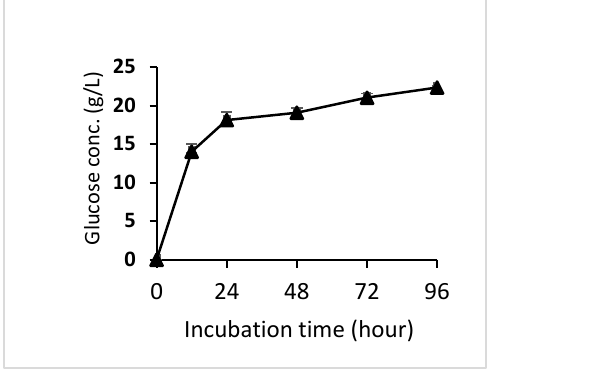
Figure 3. Glucose from OPEFB residue hydrolysis using cellulase ( a ); Ethanol fermentation profile ( b ), glucose (solid triangles), S.cerevisiae cell growth (solid squares), and ethanol (solid diamond). The data shown are the average of three replicate studies, and the error bars show the standard deviations.